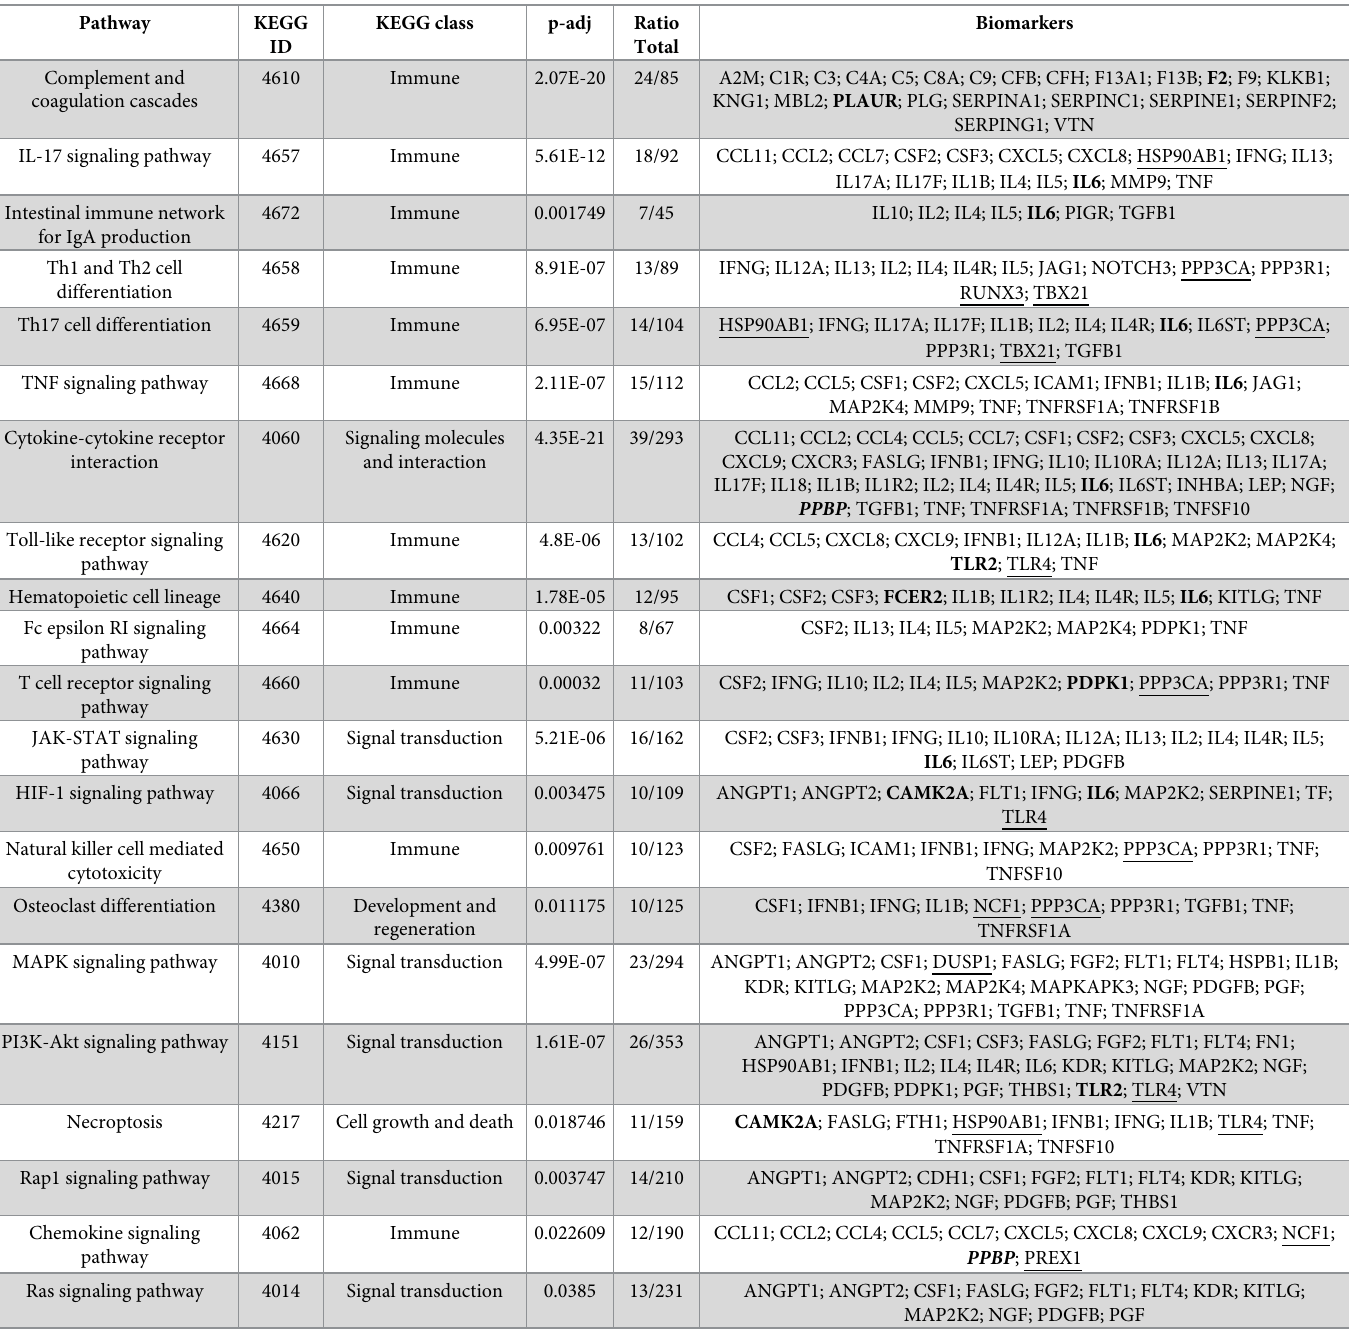
Table 3. Enriched pathways within the set of